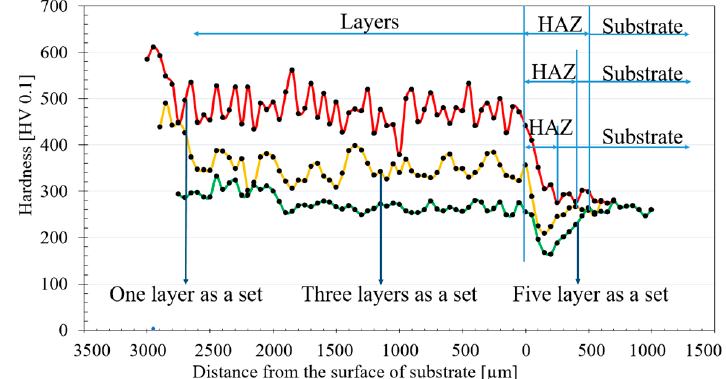
ff erent build-up